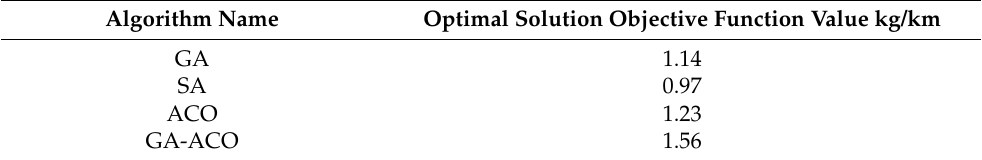
Table 3. Comparison of objective function values of optimal solutions of various algorithms.